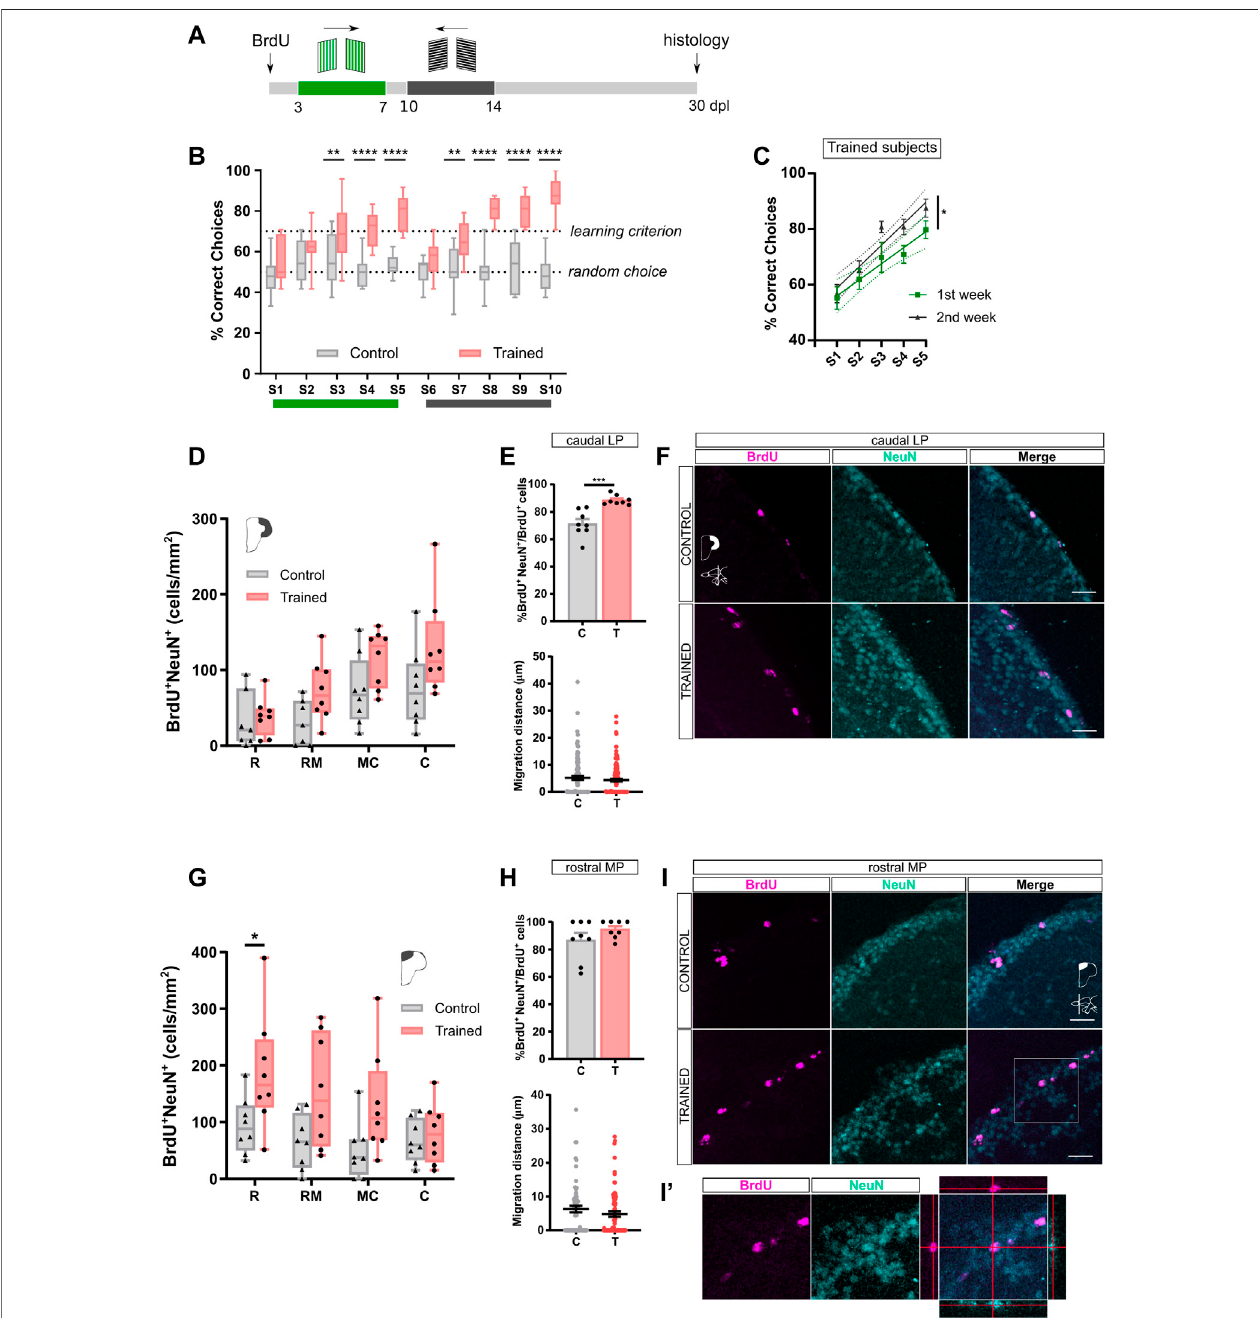
FIGURE3 | Training zebra fi shduring anearly period (3 – 14 dpl) increases adult neurogenesis in therMP. (A) . Experimental design. (B) . Learning curves for Trained and Control individuals (Two-way RM ANOVA, Treatment effect: F (1, 14) = 126.1 with p < 0.0001, Session effect: F (9, 126) = 5.254 with p < 0.0001. Bonferroni ’ s multiple comparisons test, ***depicts p < 0.001,****, p < 0.0001.Trained, N=8;ControlN=8). (C) .Simplelinearregressionforeach training windowforTrained fi sh(ANCOVA, F (1,76) = 1.516, n. s. Trained, N=8; Control N= 8). (D) . BrdU + NeuN + cell quanti fi cation in LP. (Two-wayANOVA,Treatmenteffect:F (1,54) =10.63 with p =0.0019, Palliumregioneffect:F (3,54) =8.642with p < 0.0001.Bonferroni ’ smultiplecomparisonstest,notsigni fi cantdifferences.Trained,N=8;ControlN=8). (E) .Top:Neuronal fate(%BrdU + NeuN + /BrdU + cells) incLP.(Unpaired t test, t (14) =4.749,***depicts p < 0.001.Trained,N=8;ControlN=8).Bottom:CellmigrationincLP(MannWhitney test,U=6492,n.s.Trained, N=8;ControlN=8). (F) .Adult-bornneurons(BrdU + NeuN + )incLPforTrainedandControlindividuals.Scalebar,20 μ m. (G) .BrdU + NeuN + cellquanti fi cationinMP.(Two-wayANOVA, Treatmenteffect:F (1,56) =15.34with p =0.0002,Pallium regioneffect:F (3,56) =2.685with p =0.0553.Bonferroni ’ smultiple comparisons test, * depicts p < 0.05. Trained, N = 8; Control N = 8). (H) . Top: Neuronal fate (%BrdU + NeuN + /BrdU + cells) in rMP (Unpaired t test, t (14) = 1.396, n. s. Trained, N= 8; Control N = 8). Bottom: Cell migration in rMP (Mann Whitney test, U = 2088, n. s. Trained, N= 8; Control N = 8). (I) . Adult-born neurons (BrdU + NeuN + ) in rMP for Trained and Control individuals. Scale bar, 20 μ m. (I ’ ) . Higher magni fi cation of the boxed square in I (merge panel). Single focal plane and orthogonal views after three-dimension